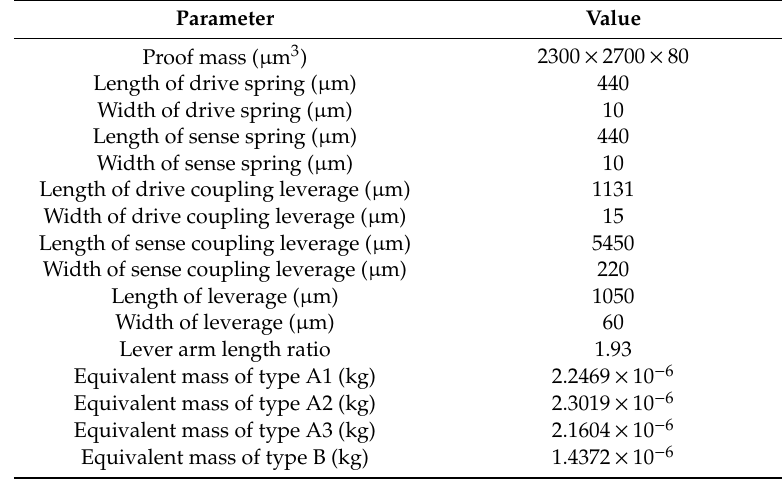
Table 1. Main parameters of the structures.